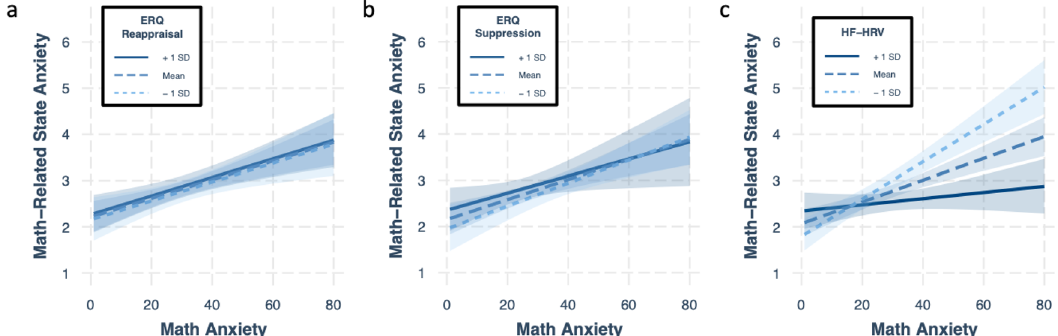
Fig. 3 Moderating effect of emotion regulation indices on the math anxiety-state anxiety link. Results of simple slope analyses generated by multiple regressions that assess whether measures related to emotion regulation moderate the association between math anxiety and math-related state anxiety. In each multiple regression model, general anxiety and self-reported anxiety during Word blocks were included as covariates. The shaded area around each line of best fi t re fl ects 95% con fi dence